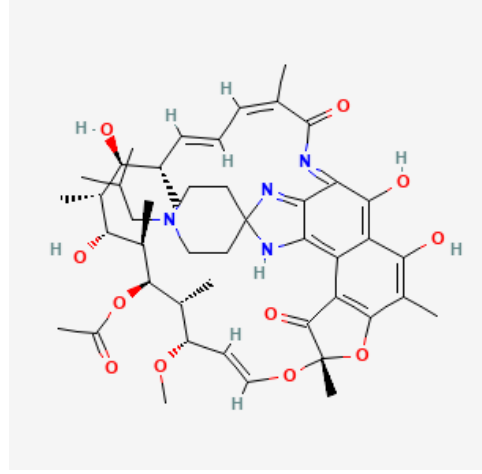
Figure 6. 2D chemical structure of rifabutin.